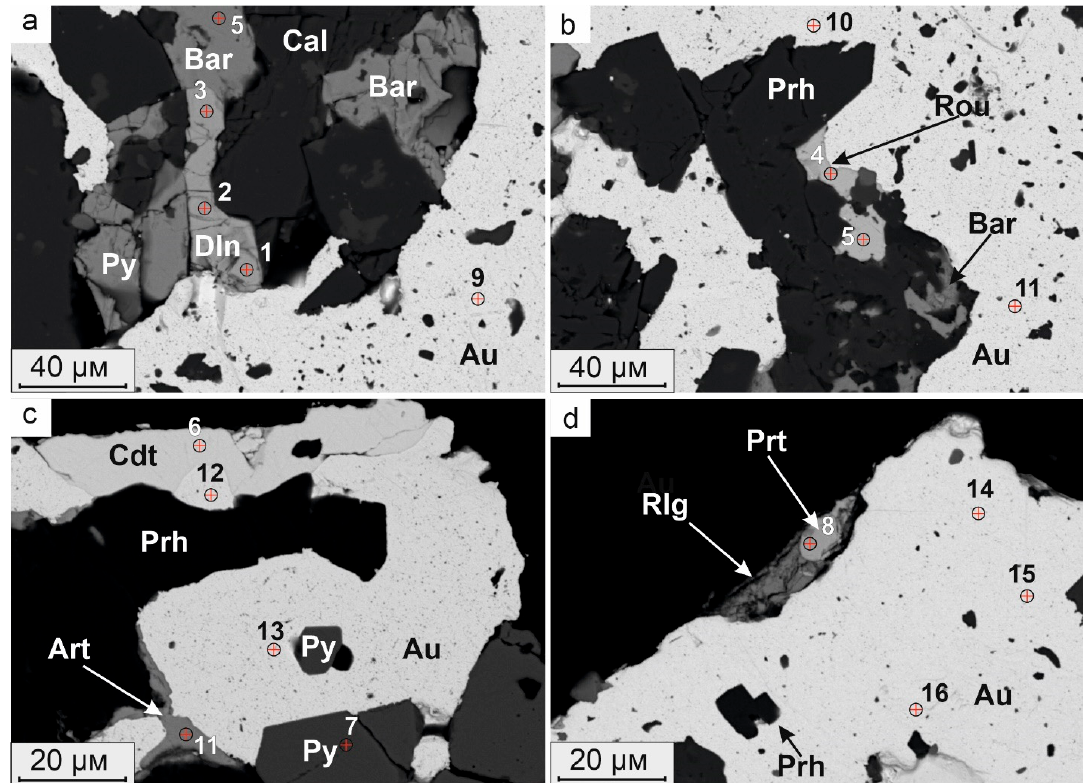
Figure 9. BSE-photo of the minerals intergrown with gold from realgar-orpiment cement breccia. Analyses corresponding to 1–8 point numbers are given in Table 2; the analyses of native gold No. 9–16 are given in Table 3. ( a ) Polymineral inclusions, consisting of calcite (Cal), barite (Bar), pyrite (Py) and dalnegroite (Dln); ( b ) polymineral inclusions formed by prehnite (Prh), barite and routhierite (Rou); ( c ) coloradoite (Cdt) and arsenolite (Art) intergrown with gold; ( d ) parapierrotite (Prt), realgar (Rlg) and prehnite crystals in native gold.